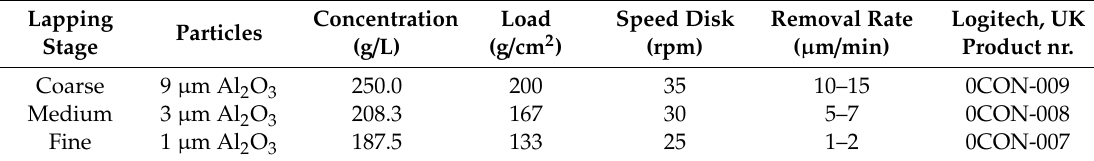
Table 1. Settings for the di ff erent lapping stages of KY(WO 4 ) 2 *.